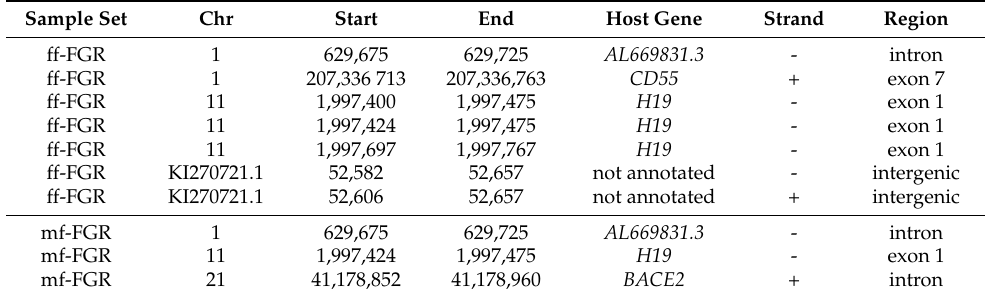
Table 6. All detected circular RNA molecules in ff-FGR and mf-FGR samples.